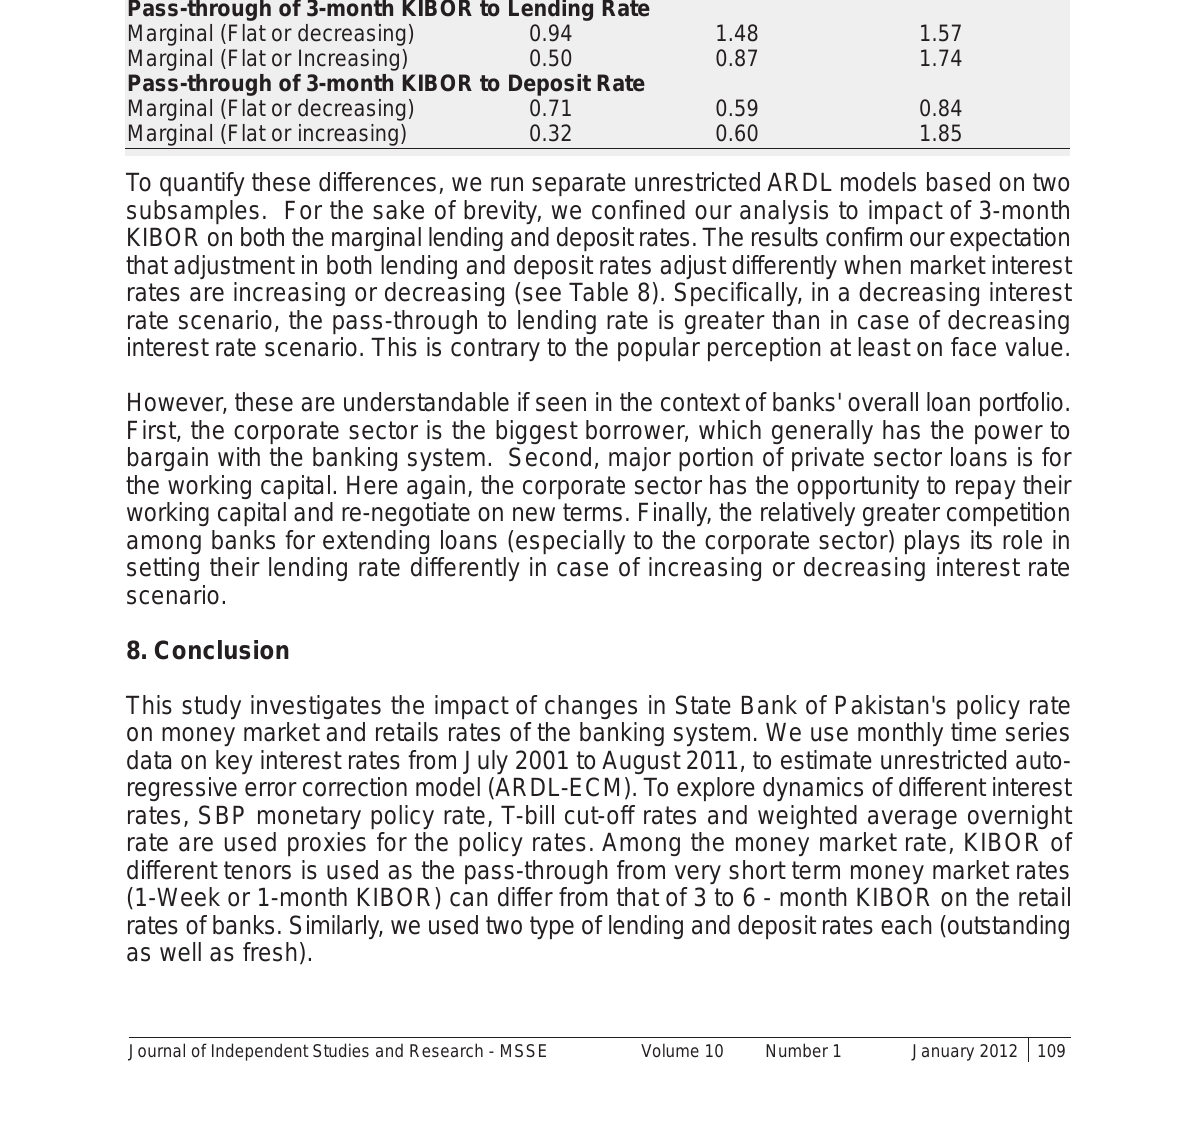
Table 8: Asymmetric Pass-through of Money Market Rates to Banks' Retail Rates Short Run Long Run Approximate Time Pass-through of 3-month KIBOR to Lending Rate Marginal (Flat or decreasing) 0.94 1.48 1.57 Marginal (Flat or Increasing) 0.50 0.87 1.74 Pass-through of 3-month KIBOR to Deposit Rate Marginal (Flat or decreasing) 0.71 0.59 0.84 Marginal (Flat or increasing) 0.32 0.60